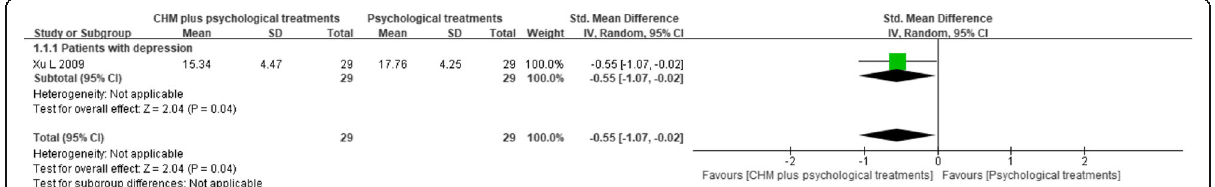
Fig. 5 Forest plot of mean depression scores for CHM plus psychological treatments versus psychological treatments alone